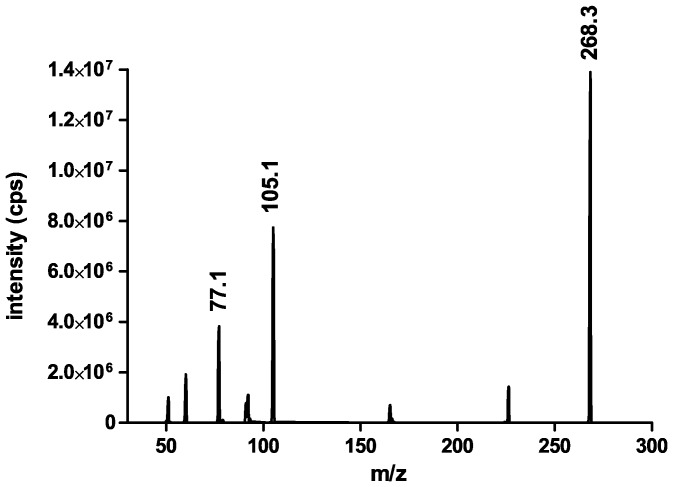
LC-MS/MS spectrum of methadone-d3, quantifier ion 268.3 m/z.